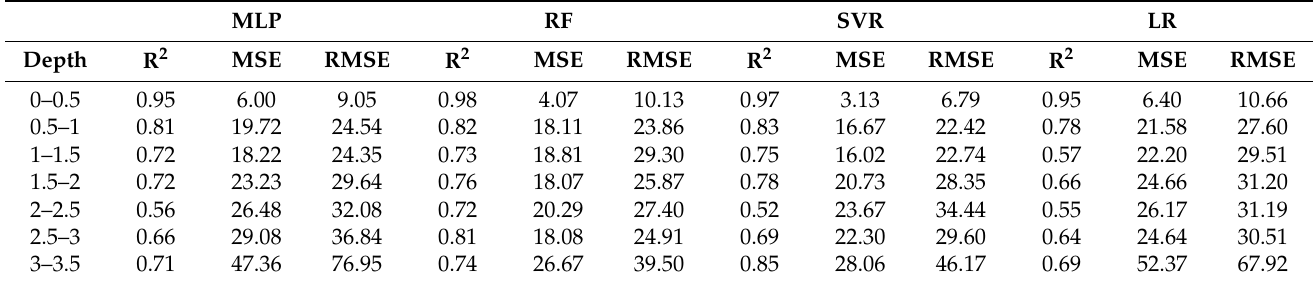
Figure 19. Coefficient of determination for all of the algorithms. The values of mean square error (MSE), RMSE, and R 2 are given in Table 5. Table 5. MSE, RMSE, and R 2 for